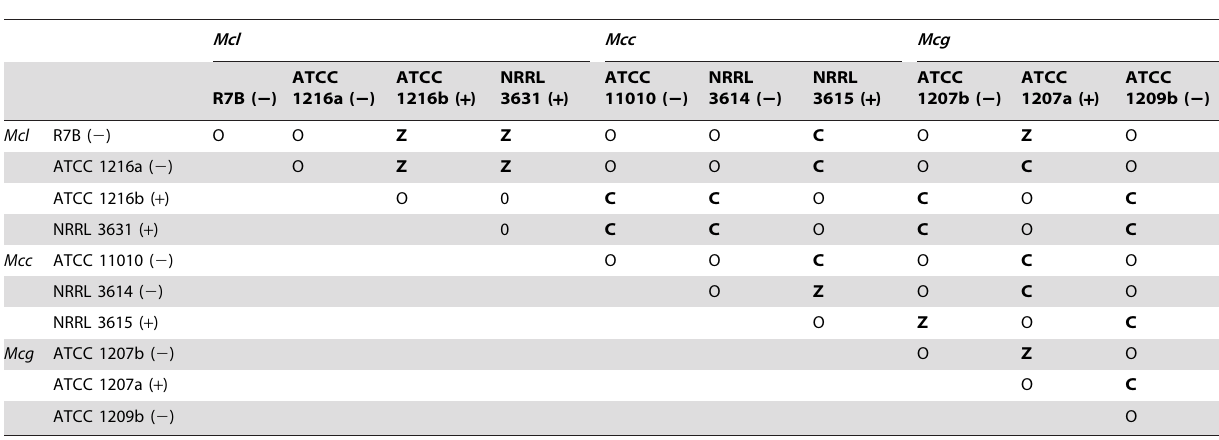
Table 3. Sexual reproduction of the M. circinelloides